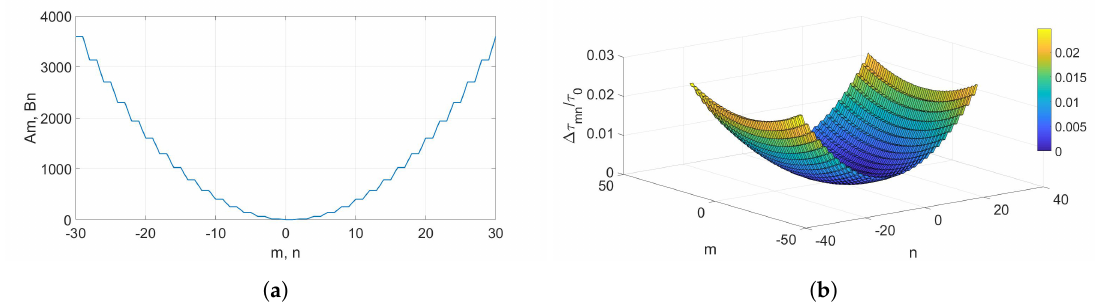
Figure 3. ( a ) A m and B n dependence for the n and m orders. ( b ) τ ( m , n ) / τ 0 dependence for n and m values, where a = 0.5 m, b = 1 m, and z = 300